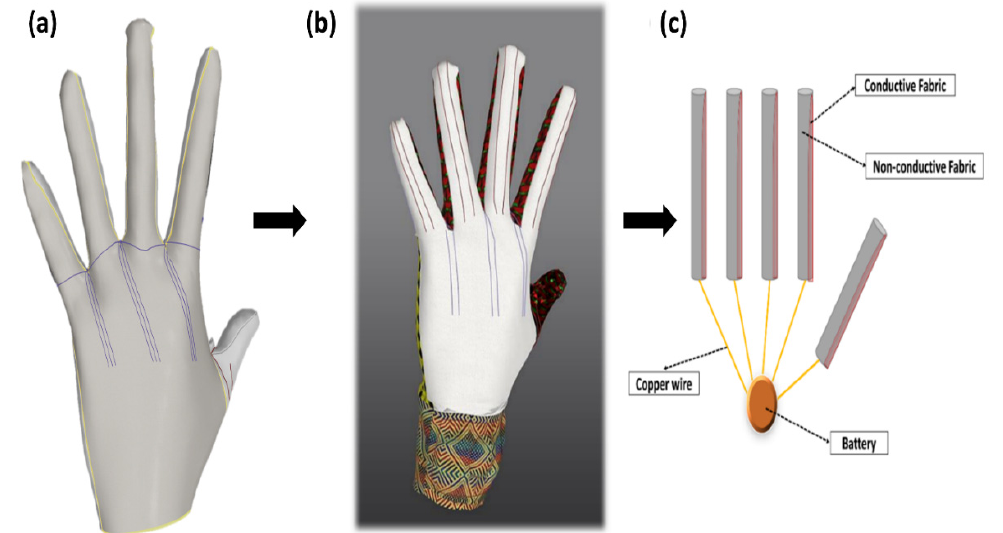
Figure 11. Thermal glove for RP patients: ( a ) wool glove interline, ( b ) glove design, and ( c ) glove assembly.